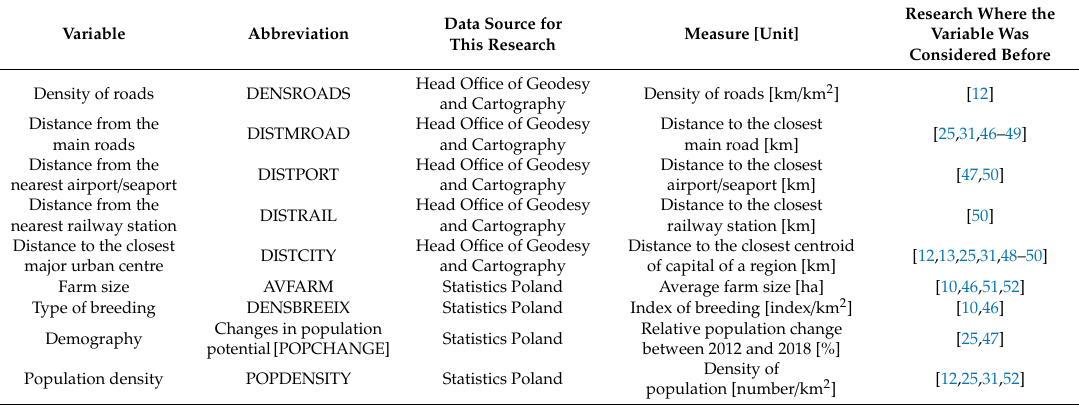
Table 1. Description of determinants of land cover or land use